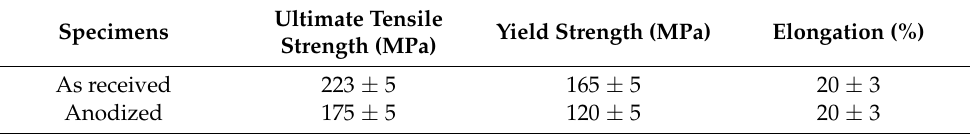
Figure 4. Stress-strain curves in uniaxial tensile tests at room temperature. Table 2. Stress-strain curves in uniaxial tension tests at room temperature for anodized and as received